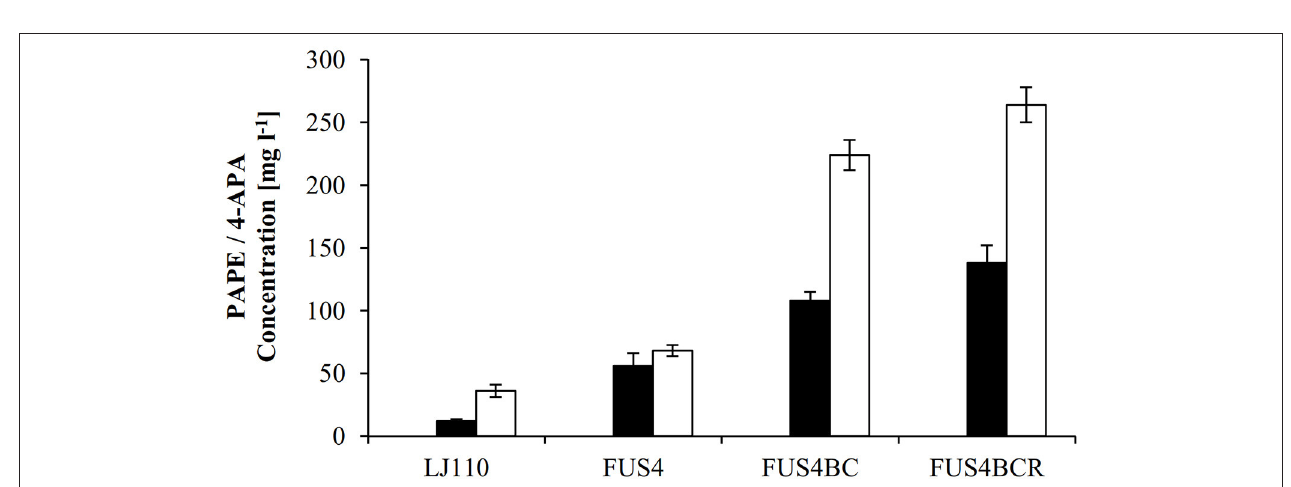
FIGURE 3 | Overview of PAPE or 4-APA production by different E. coli strains. The E. coli strains LJ110, FUS4, FUS4BC, and FUS4BCR with either pC53BCA for PAPE production (filled columns), or with pC53BCAF for 4-APA production (empty columns) were compared. The PAPE and 4-APA titers were determined by HPLC measurements after 48h batch cultivation in minimal media with 4.5g l − 1 glucose. The data represent the mean and standard deviations from measurements of three biological